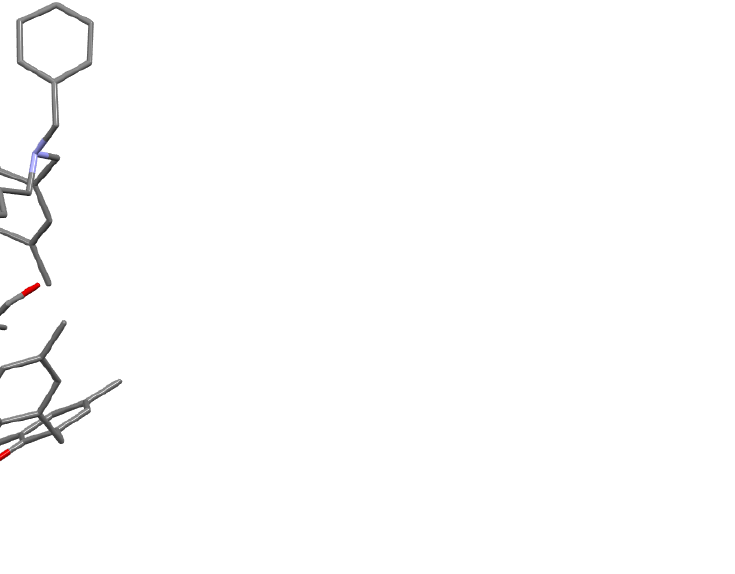
Figure 7. DMF inclusion capsule by p -me- N -benzyl-azacalix[3.1.1.1]arene.